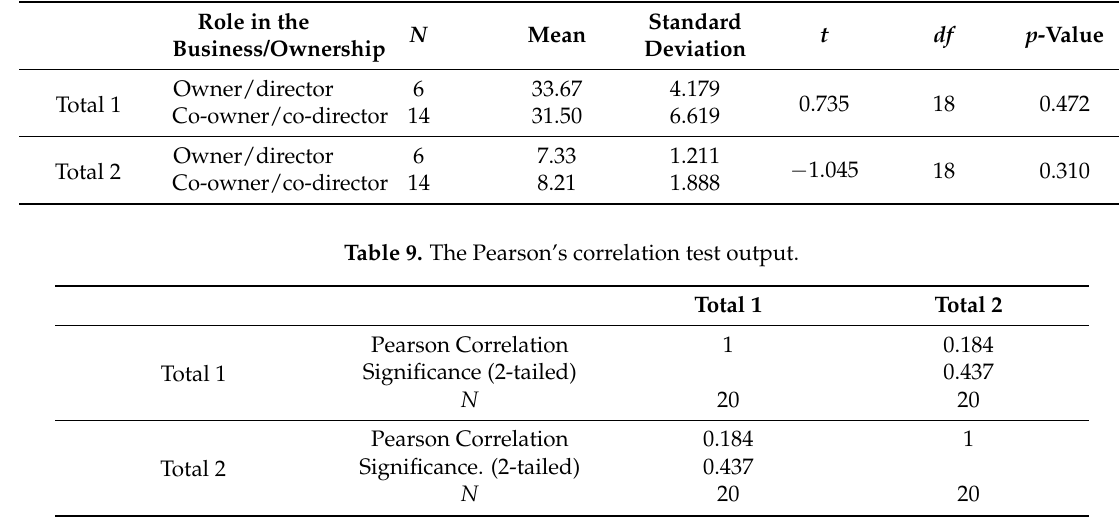
Table 8. Group Statistics.